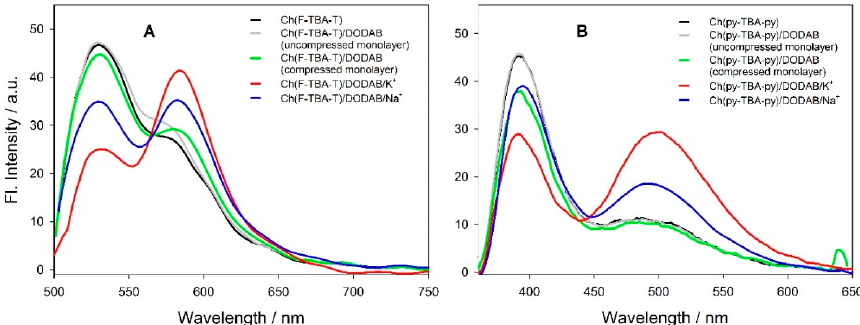
Figure 5. Emission spectra for Ch(F-TBA-T) ( A ) and Ch(py-TBA-py) ( B ) probes at monolayer interface: probe in subphase (black line), after DODAB monolayer spreading (grey line); after DODAB monolayer compression to 20 mN/m (green line); after K + addition (red line); and, after Na + addition (blue line). Conditions: subphase contained 10 mM TA buffer (pH = 7.5) and 40.0 nM probe; 100 mM KCl or NaCl.